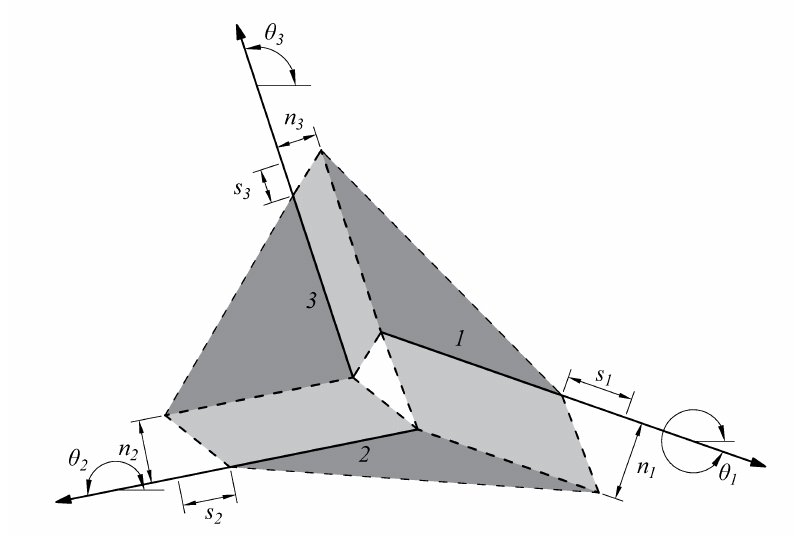
Figure 2. Compatibility conditions at